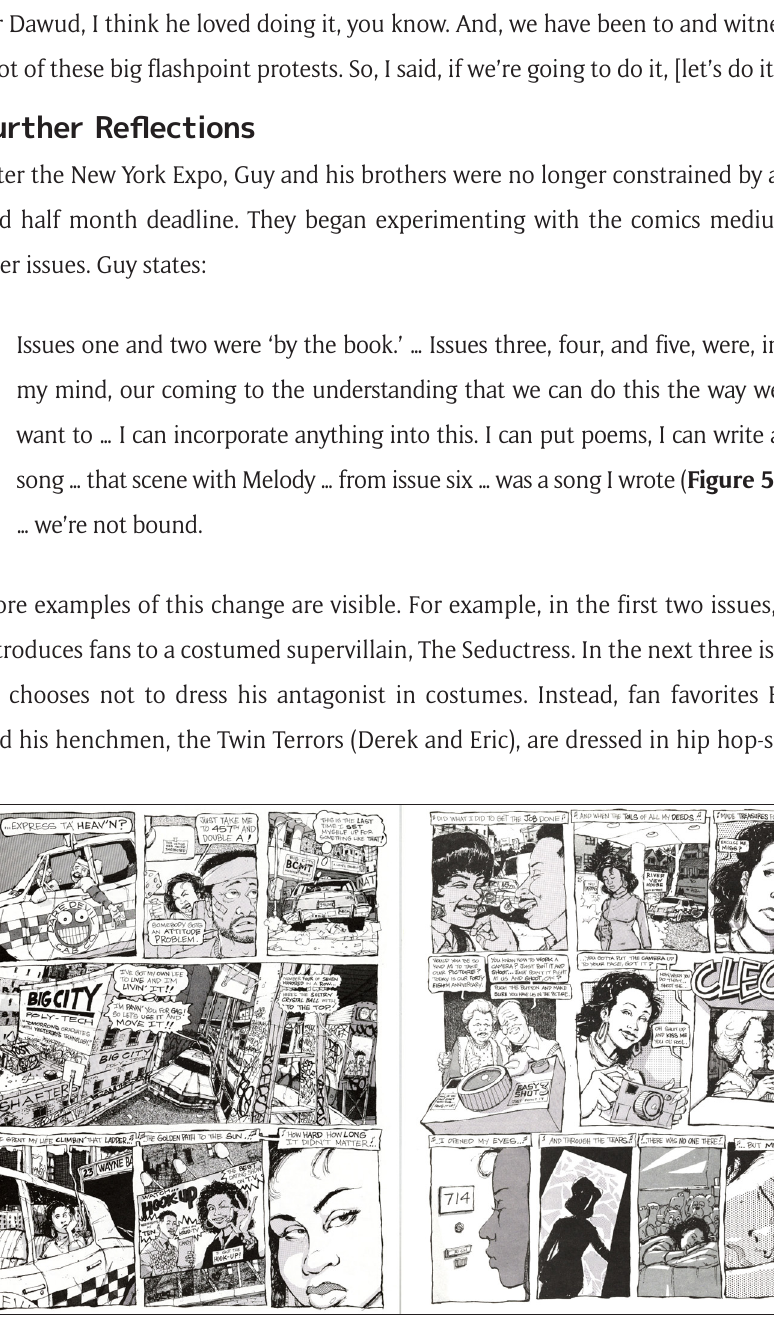
Figure 5: Excerpt from Sims J, Sims D, and Sims G (1992b) Brotherman: Dictator of Discipline #6 (East Orange, NJ) © Big City Entertainment,